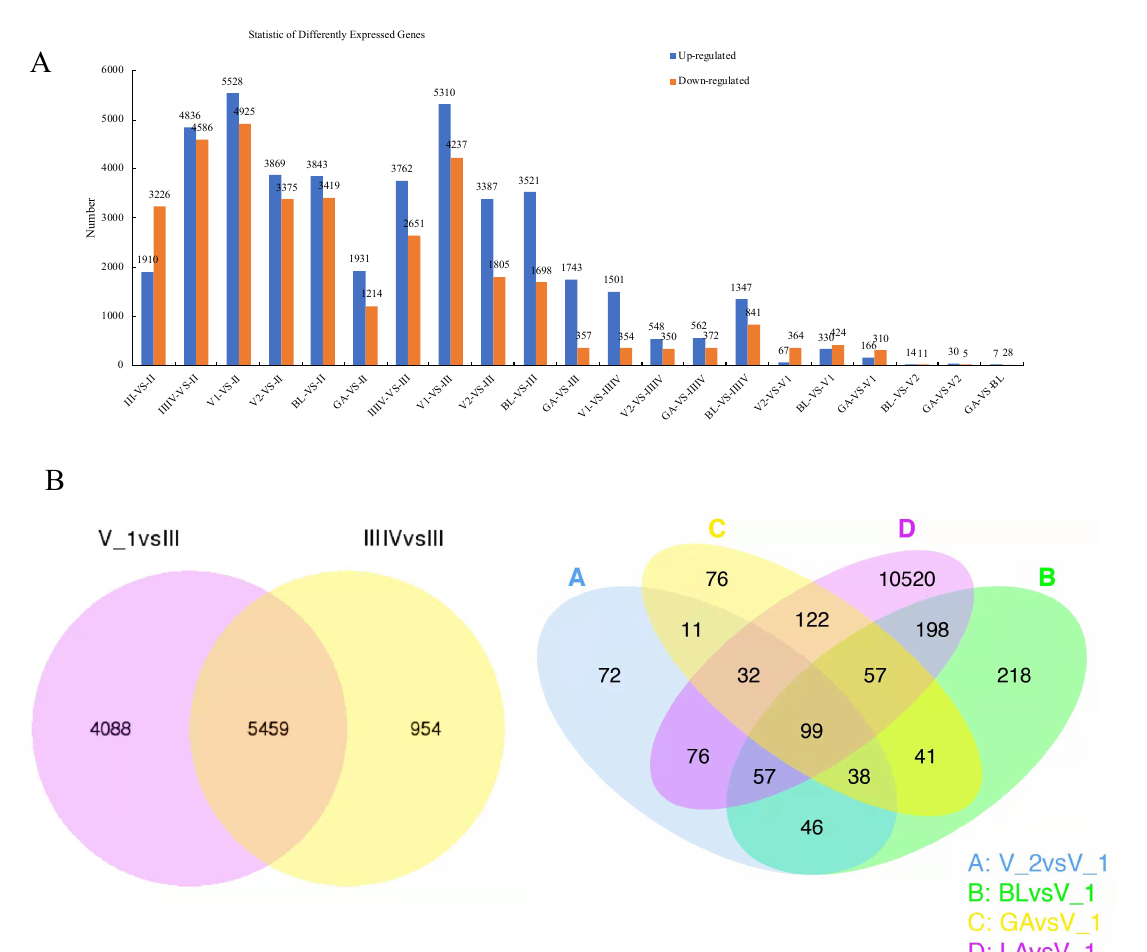
Figure 3. DEGs between the different ovarian developmental stages. ( A ) Summary of DEGs. The x-axis represents compared samples. The y-axis represents DEG numbers. The blue colour represents upregulated DEGs and the orange colour represents downregulated DEGs. ( B ) Venn diagram of ovarian transcripts from different reproductive phases.